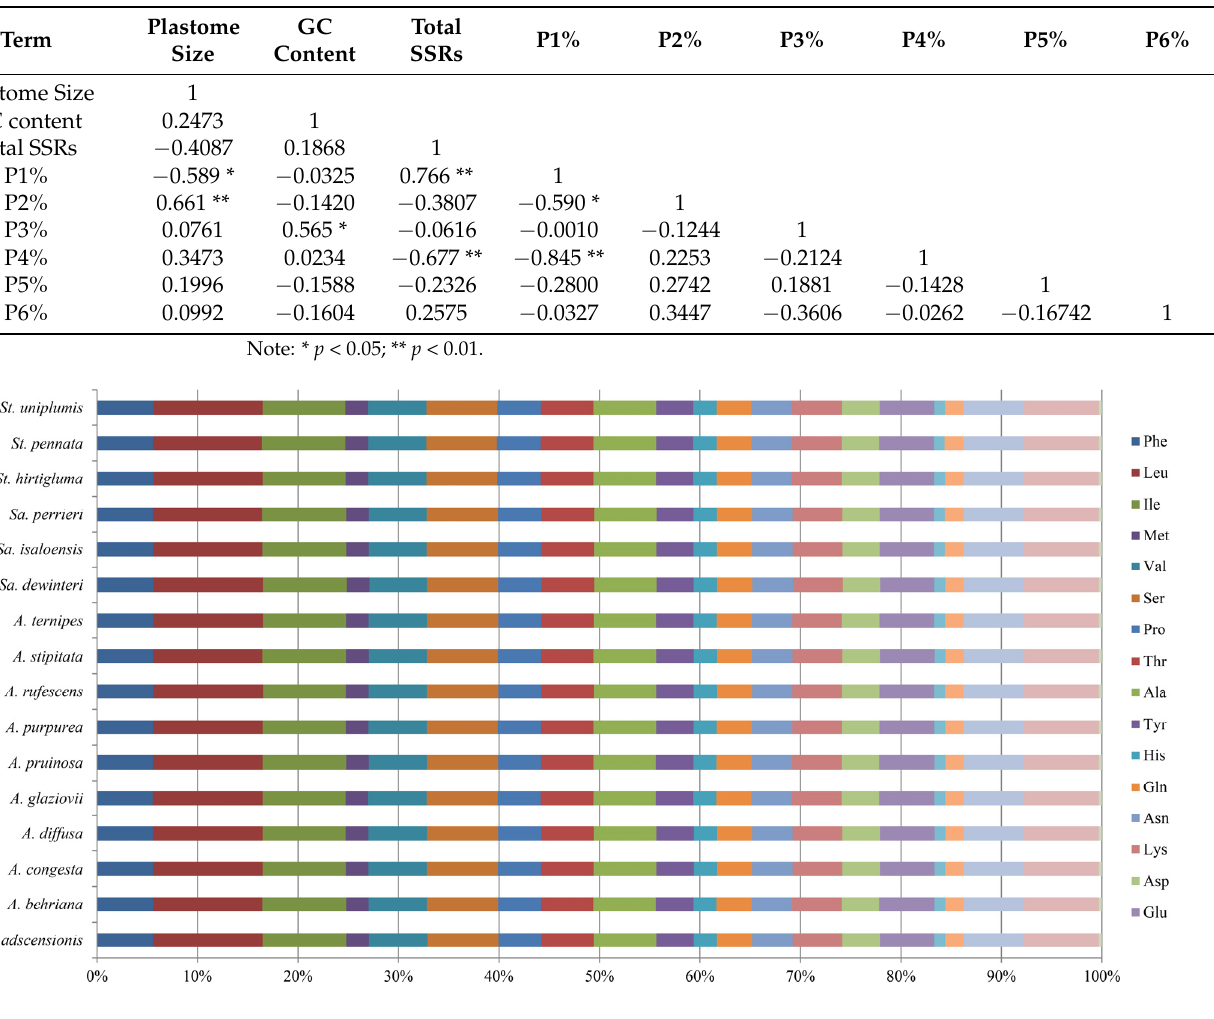
Figure 3. Comparison of the amino acid composition in the plastomes of 16 Aristidoideae